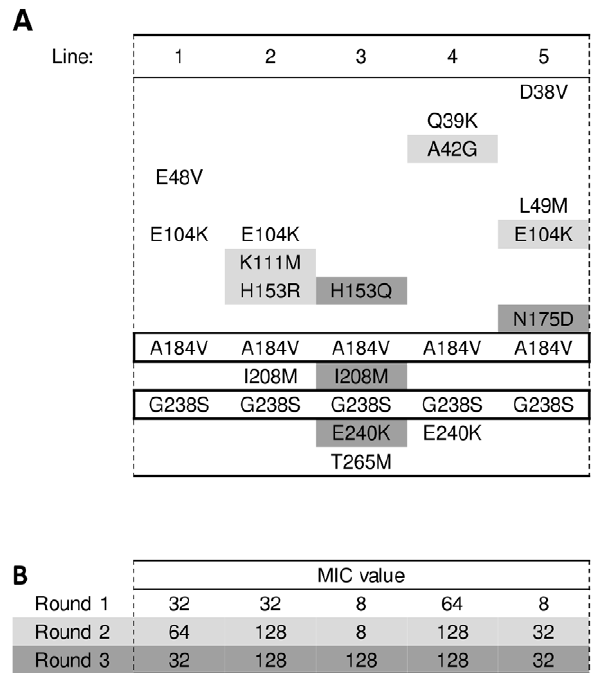
Figure 4. Amino acid substitutions in evolved TEM double- mutant A184V/G238S. (A) See legend of Figure 2A for details. The substitutions present in the starting alleles and still present at the end of the experiment have been highlighted by a thick-lined box. (B) See legend of Figure 2B for details.